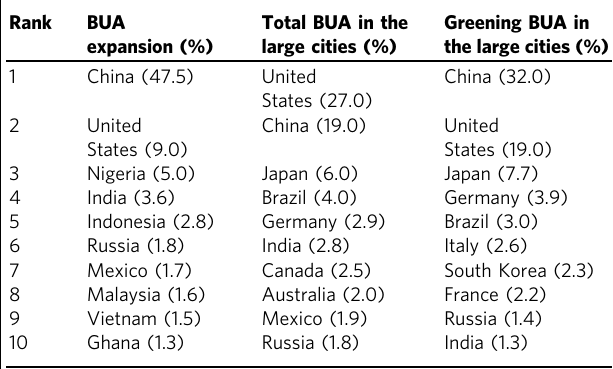
Table 1 Ranking of the top 10 countries by percentages of the total built-up area (BUA) expansion, BUA in the large cities, and greening BUA in the large